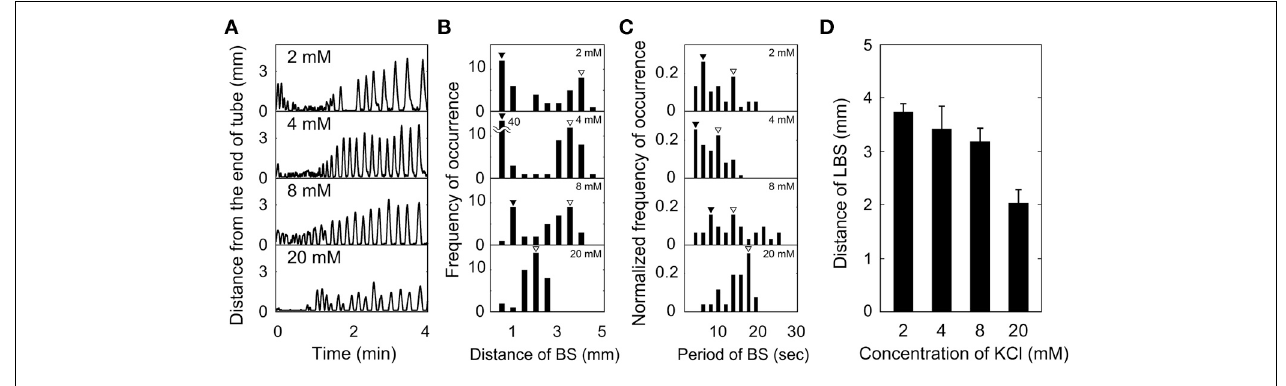
FIGURE 3 | Effect of potassium ion concentration on backward swimming (BS) of Paramecium in a dead-ended capillary. (A) Time-courses of distance from capillary end. (B) Distribution of backward swimming distances. (C) Distribution of time periods of backward swimming.